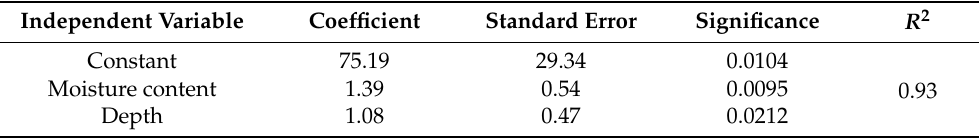
Table 3. Logistic regression fitting of occurrence probability during the sub-surface